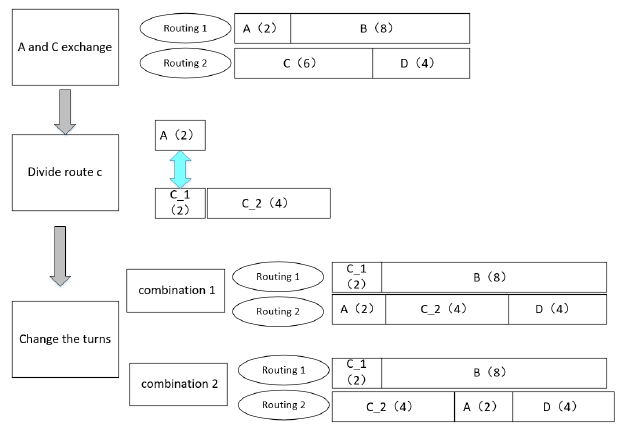
Figure A1. Exchange operator.